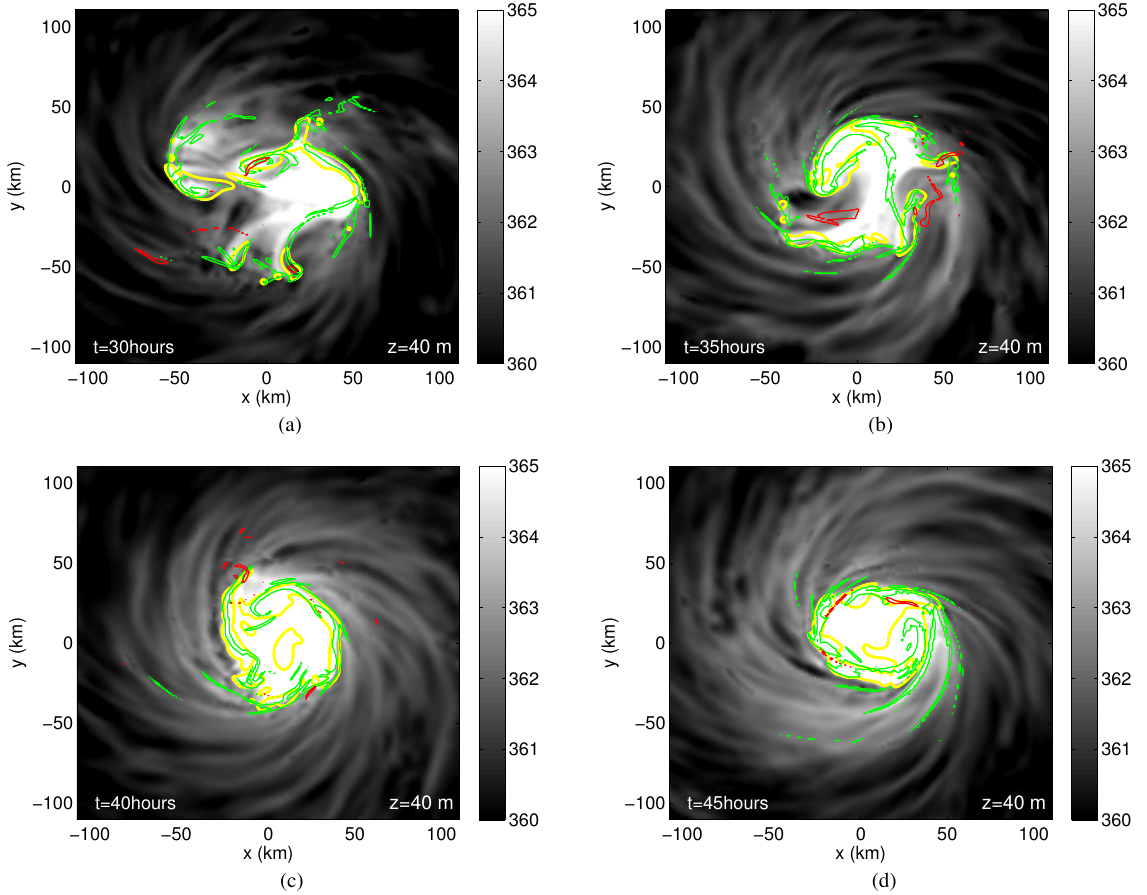
Fig. 16. The primary Lagrangian structures present during primary eyewall formation at the bottom of the boundary layer as described in section 4.6 are labeled by arrows and are shown at 30 hours (a), 35 hours (b), 40 hours (c), and 45 hours (d). Attracting Ψ -LCSs (green), repelling Ψ -LCSs (red), and vorticity contours (yellow) are all overlaid on the θ e field (black and white shading).